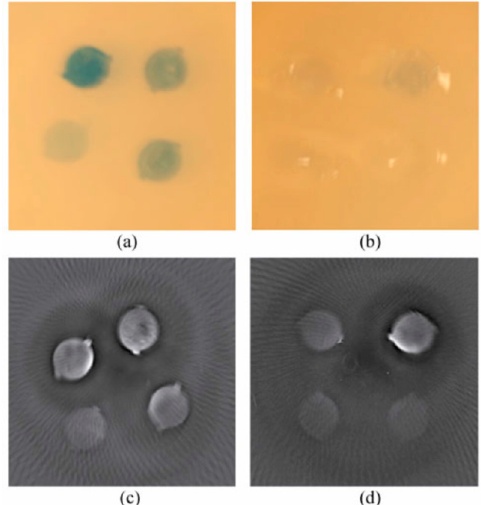
Figure 4. ( a , b ): photographs of phantoms with concentrations varying from 0.5 mg/mL (upper left corner of ( a )) to 0.01 mg/mL (lower right corner of ( b )) ( c , d ): optoacoustic images of the respective phantoms. Figure from [63] reproduced with permission from the publisher.